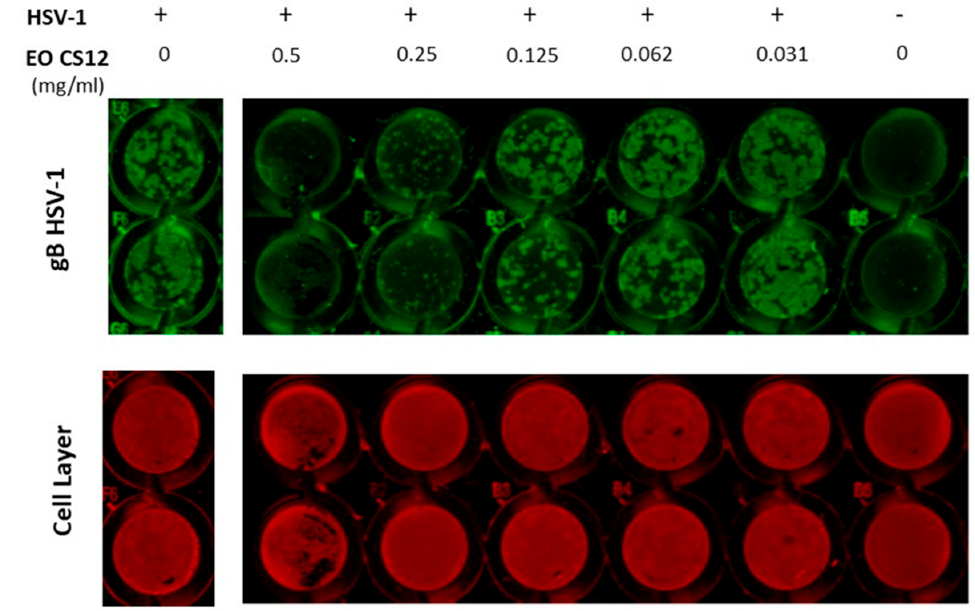
Figure 2. In cell western (ICW) analysis of anti-HSV-1 effects of EO (68, CS12). 0.1 m.o.i. HSV-1-infected Vero cells were treated for 24 h with serial dilutions of EO 68 ranging from 0.0312 to 0.5 mg/mL. Untreated HSV-1-infected cells (0 mg/mL EO) were used as comparative control. Fixed cells were incubated with anti-gB primary antibody and then with IRDye 800 CW secondary antibody (green fluorescence) and CellTag 700 Stain (red fluorescence). HSV-1 is a mock infected cell (used as staining control).